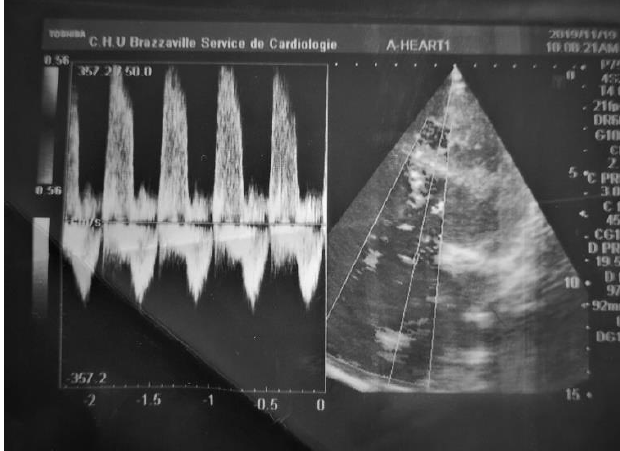
Fig. 1. Doppler Echocardiography shows severe aortic insufficiency. Computed tomography of the aorta noted dilation of the ascending aorta (58.5 x 43.2 mm) and descending aorta (40.7 mm) with a fusiform aneurysm [Fig.